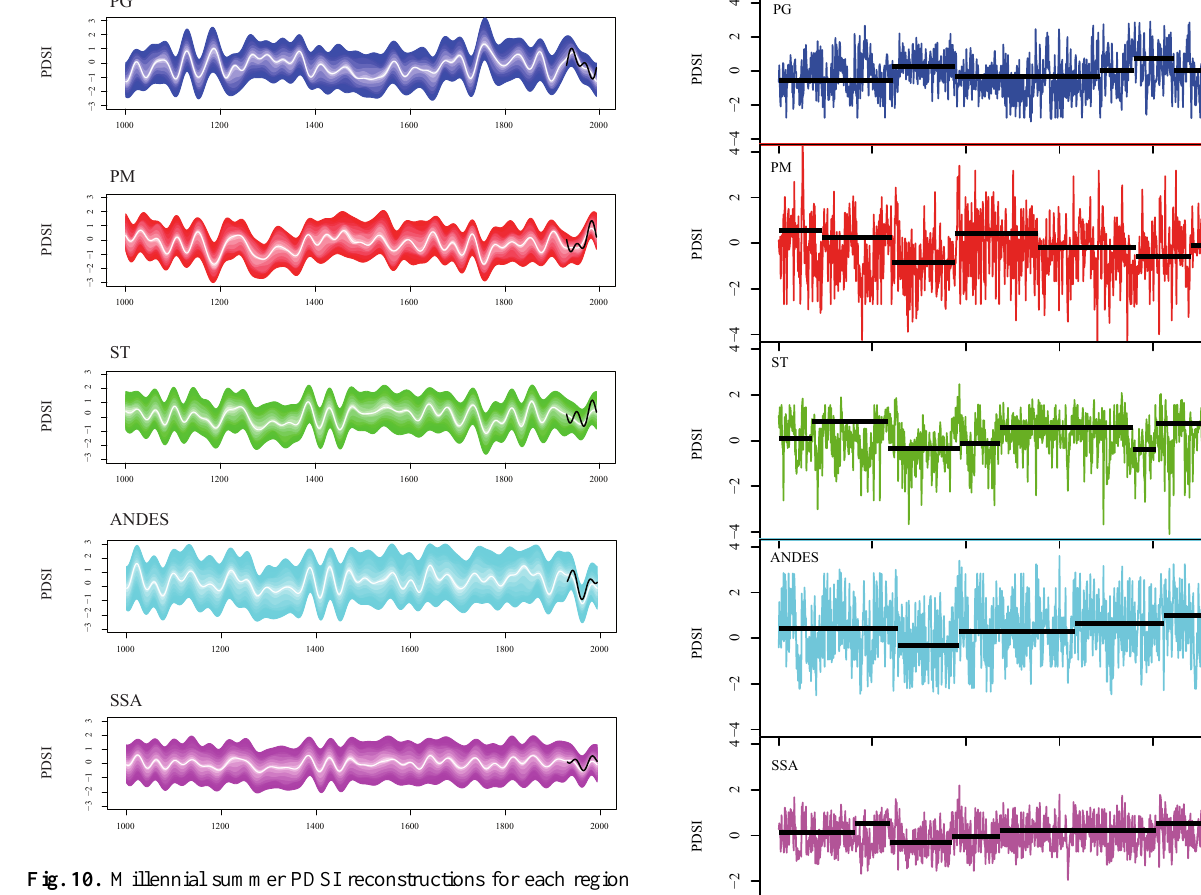
Figure 11. Regime shift detection in summer PDSI series in SSA. The analysis was performed using the Rodionov (2004) method. Regime shift detection is based on a sequential a t -test algorithm.To be detected, a regime needs to be at least 50 year long. If a regime has less than 50 years, the method can still allow for its detection, however, the significance required to determine that a date corresponds to a changepoint is adjusted to be inversely related to the length of the regime. The bottom panel corresponds to the 20 year running proportion of the number of series recording a changepoint at year t . It gives a general idea of where these changepoints cluster in time. Color code from Figure 3 is used here.